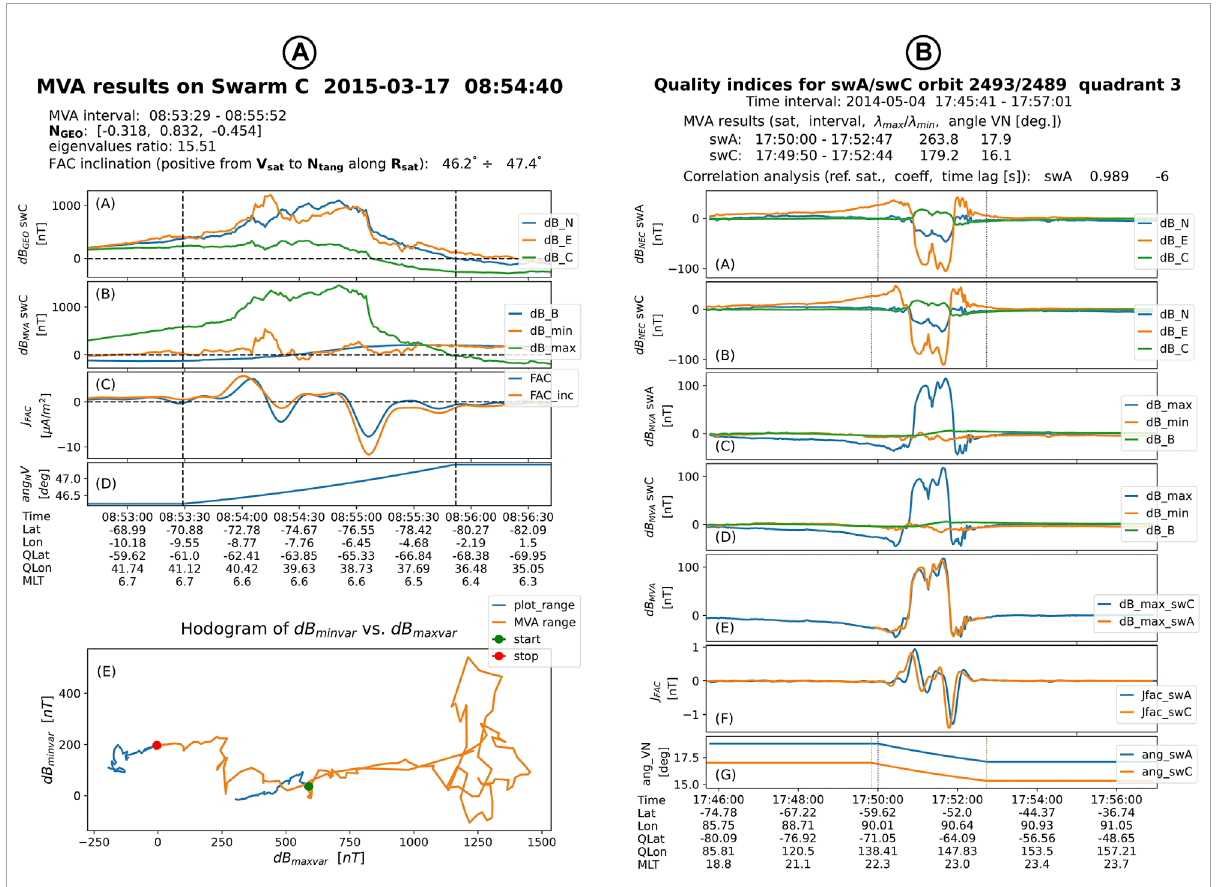
FIGURE 5 (A) : Standard plot generated by perform_mva1sat . From top to bottom the figure shows (A and B) the magnetic field perturbation in GEO frame and MVA frame, respectively, (C) a comparison between the standard and corrected for inclination FAC density estimates, and (D) the angle in the tangential plane between the FAC sheet normal and the satellite velocity vector (angle α in Figure 1B ). The hodograph of magnetic field perturbation in the plane perpendicular to the average magnetic field direction is presented in panel (E). (B) : Standard plot generated by fac_qi algorithm (data only from the lower Swarm satellites). From top to bottom the figure shows the magnetic field perturbation in NEC panels (A,B) and in MVA frames panels (C,D). The vertical dashed lines in panels (A and B) indicate the AO intervals that enter in the MVA analysis. In panel (E) the magnetic perturbations along the maximum variance directions of both sensors are plotted with the proper lag applied to the reference satellite. Panel (F) shows the (filtered) FAC densities, while panel (G) presents the current sheet inclination in the tangential